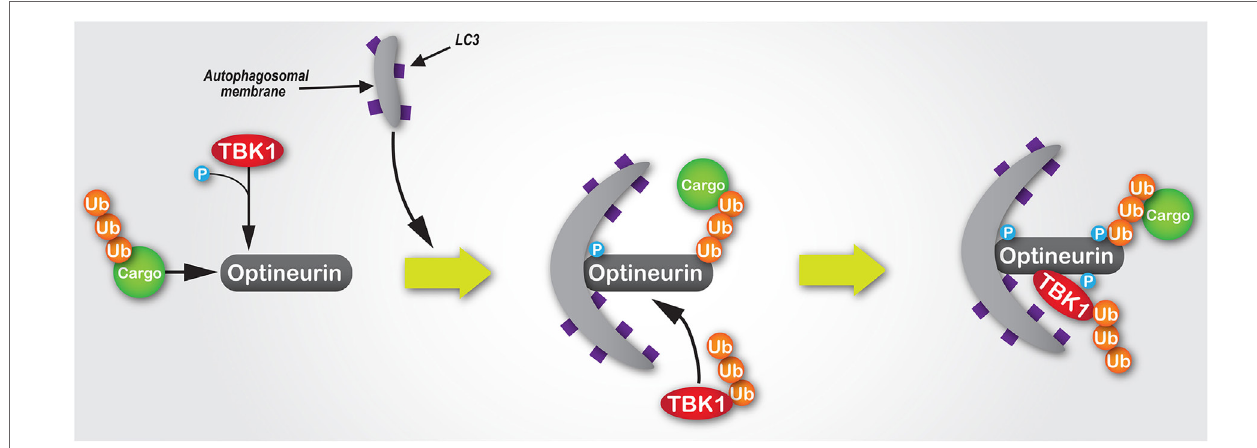
FiGURe 3 | The mechanisms of the TBK1/optineurin complex during autophagy. Optineurin interacts with ubiquitylated cargo via its UBAN and zinc finger domains. TBK1 is then recruited via an interaction with optineurin to facilitate its phosphorylation at Ser177, which enhances its light chain 3 (LC3)-binding capacity and recruitment of autophagosomal membrane. Subsequently, TBK1-mediated phosphorylation of optineurin at Ser473 and Ser513 enhances its polyubiquitin-binding capacity, thus stabilising its interaction with ubiquitin-labelled cargo. Since K63-linked polyubiquitylation of TBK1 is required for its activation, as well as its recognition and recruitment by Golgi-localised optineurin, we would hypothesise that during autophagosome formation ubiquitylated TBK1 is recruited by optineurin, where it is activated and in turn phosphorylates optineurin, thus creating a positive signal amplification loop through the recruitment and stabilisation of the TBK1/ optineurin heterodimeric complex on ubiquitylated